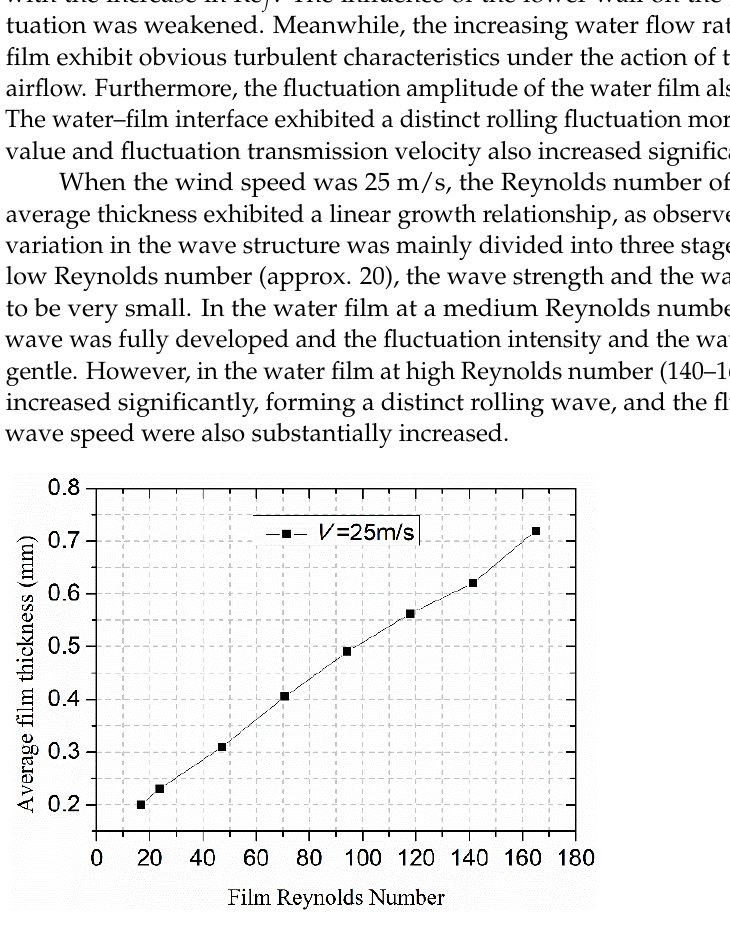
Figure 10. The variation in the Reynolds number and the average thickness of the water film.